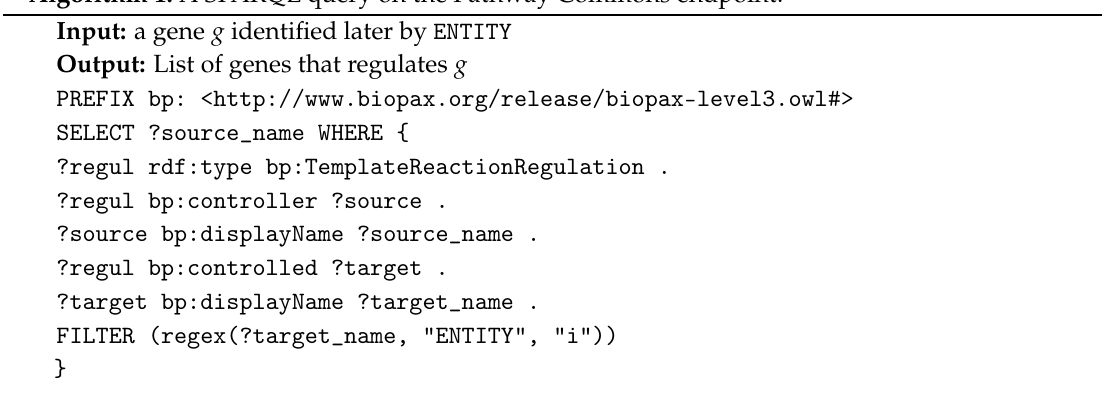
Algorithm 1: A SPARQL query on the Pathway Commons endpoint.